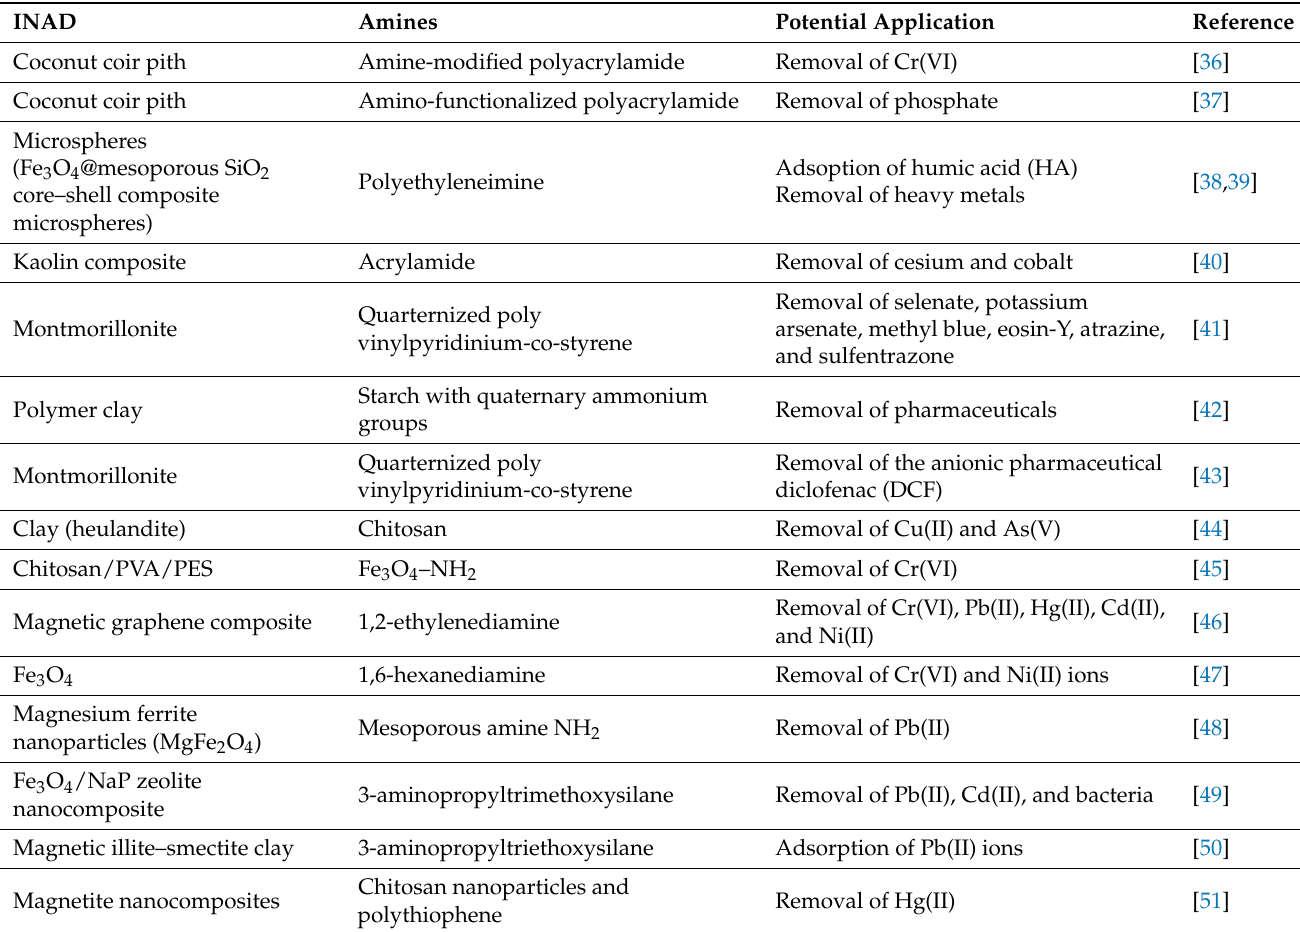
Table 1. Summarized inorganic adsorbents (INADs) functionalized by amine grafting for environ- mental